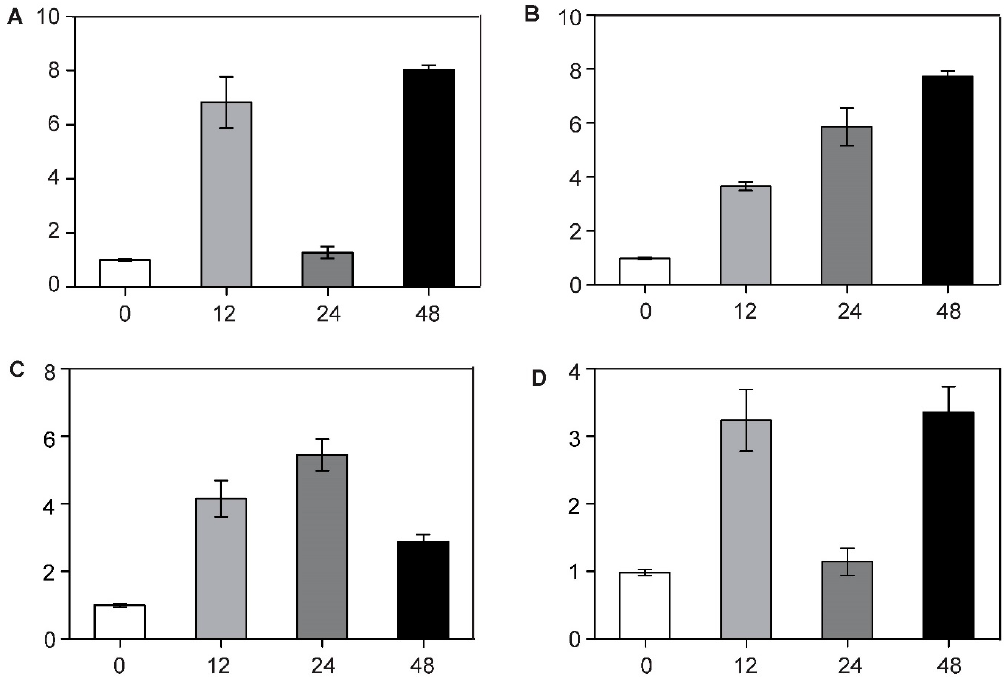
Figure 7. RT-qPCR analysis of the expression patterns of BcCSP3 in Pak-choi (leaves) under abiotic stresses. ( A ) BcCSP3 expression under ABA treatment; ( B ) BcCSP3 expression under cold treatment; ( C ) BcCSP3 expression under salt treatment; ( D ) BcCSP3 expression under dehydration treatment. Each column represents the average and standard deviation of three replicates. Each bar value represents the mean ± SD ( p <